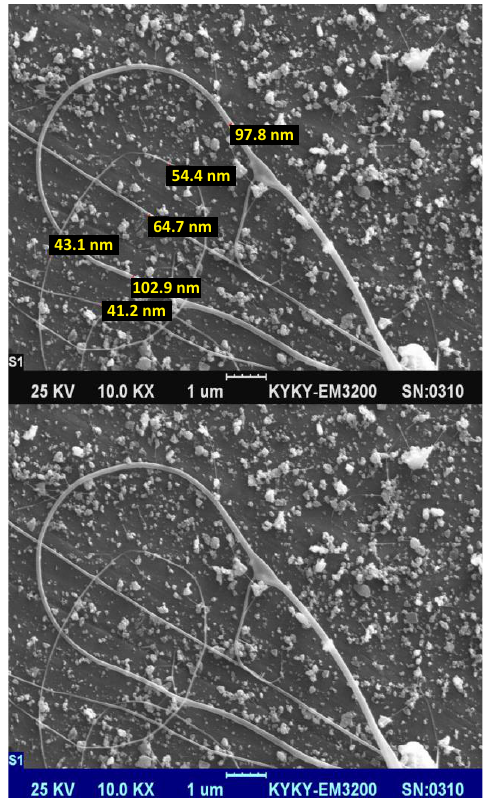
Fig. 4. SEM images of CuFe